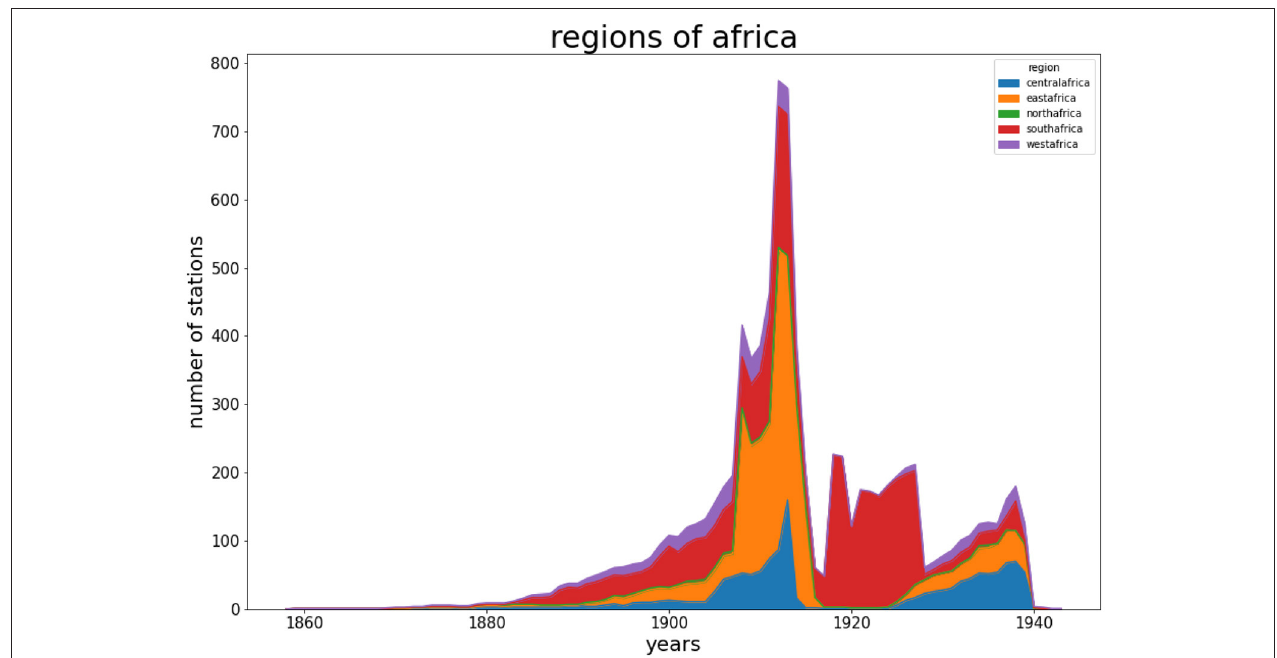
FIGURE 4 | Availability of hand-written observations in the archive of the German Naval Observatory per year. The graph shows the number of stations in specific regions of Africa. The archive contains data from the following countries which are summarized by regions (stacked in the following order); (blue: Central Africa): Angola, Cameroon, Congo, Gabon; (orange: Eastern Africa): Ethiopia, Kenya, Tanzania; (green: Northern Africa): Egypt, Morocco; (red: Southern Africa): Madagascar, Mozambique, Namibia, South Africa, St. Helena; (purple: Western Africa): Benin, Cape Verde, Equatorial Guinea, Ivory Coast, Gambia, Ghana, Guinea, Guinea-Bissau, Liberia, Mali, Senegal, Sierra Leone, Togo.